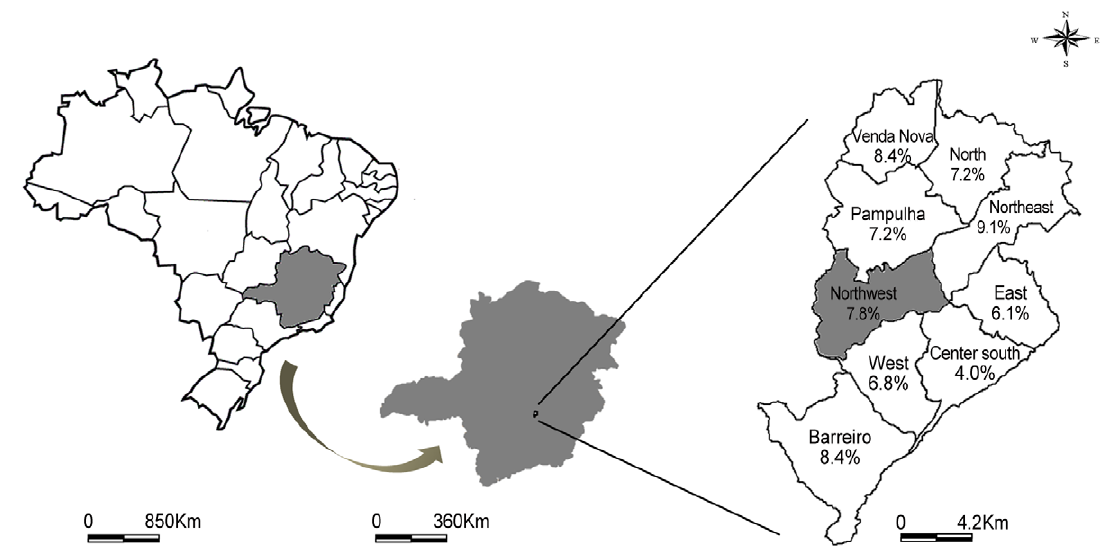
Figure 1. Municipality of Belo Horizonte, state of Minas Gerais, Brazil, subdivided into sanitary areas.